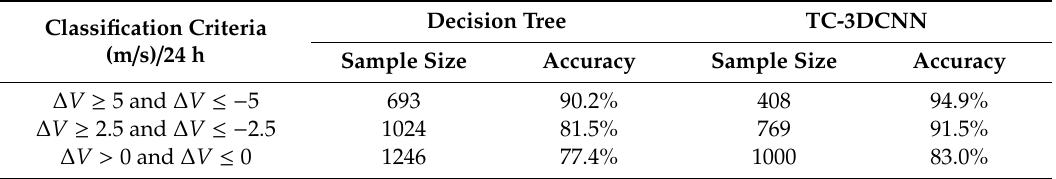
Table 5. Comparison of classification accuracy under di ff erent classification